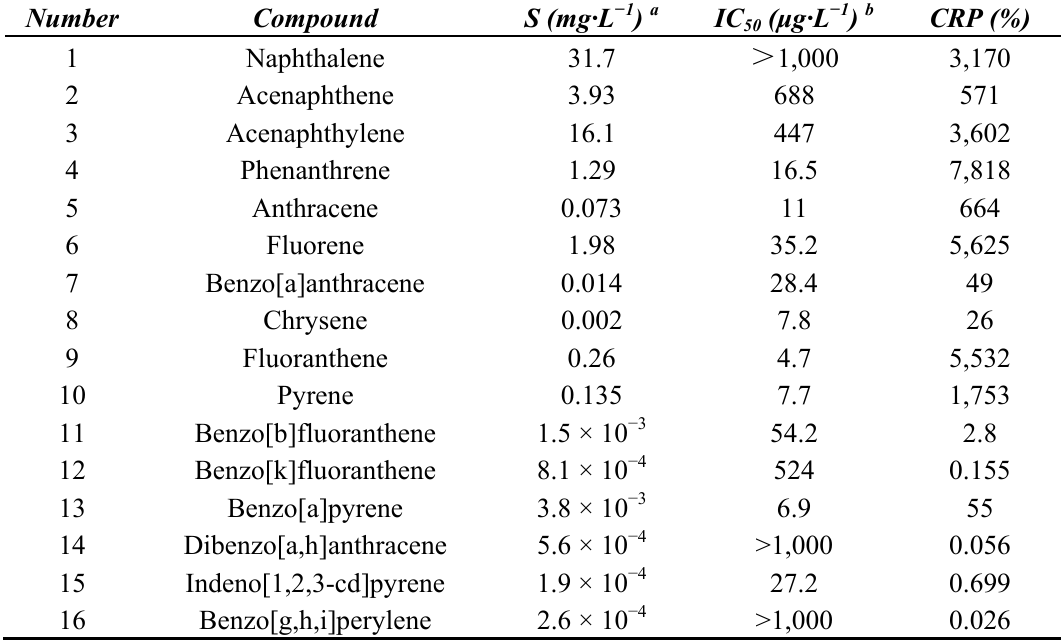
Table 3. Cross-reaction potential (CRP) of PAHs for RaPID ELISA